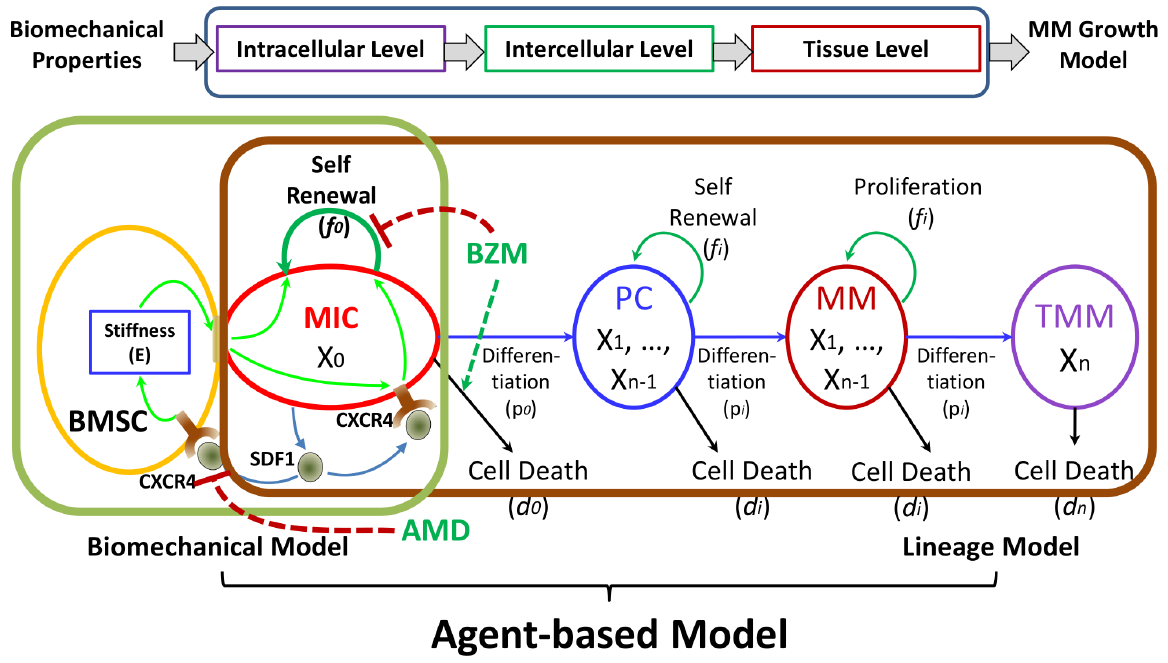
Figure 1. A sketch of ABM model.